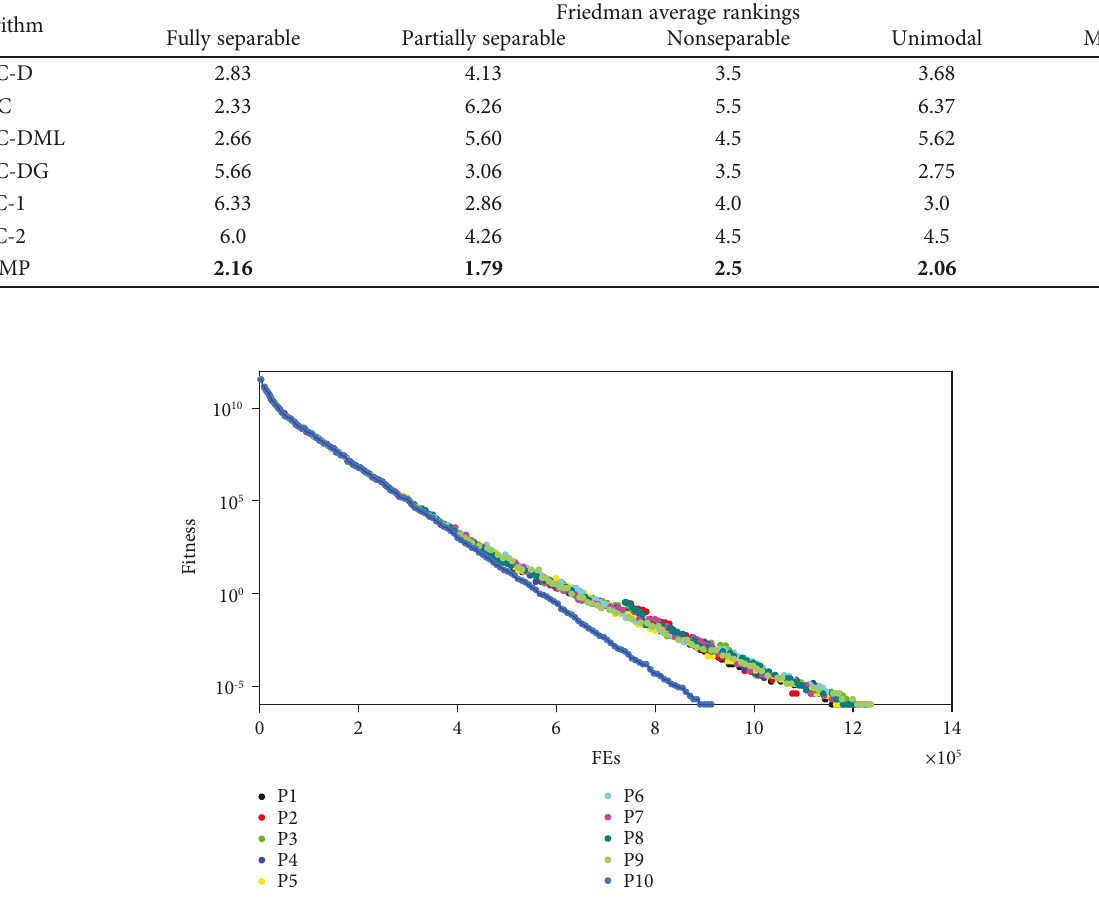
Figure 5: Convergence curves of active child populations in the 22nd subproblem when optimizing F1 .